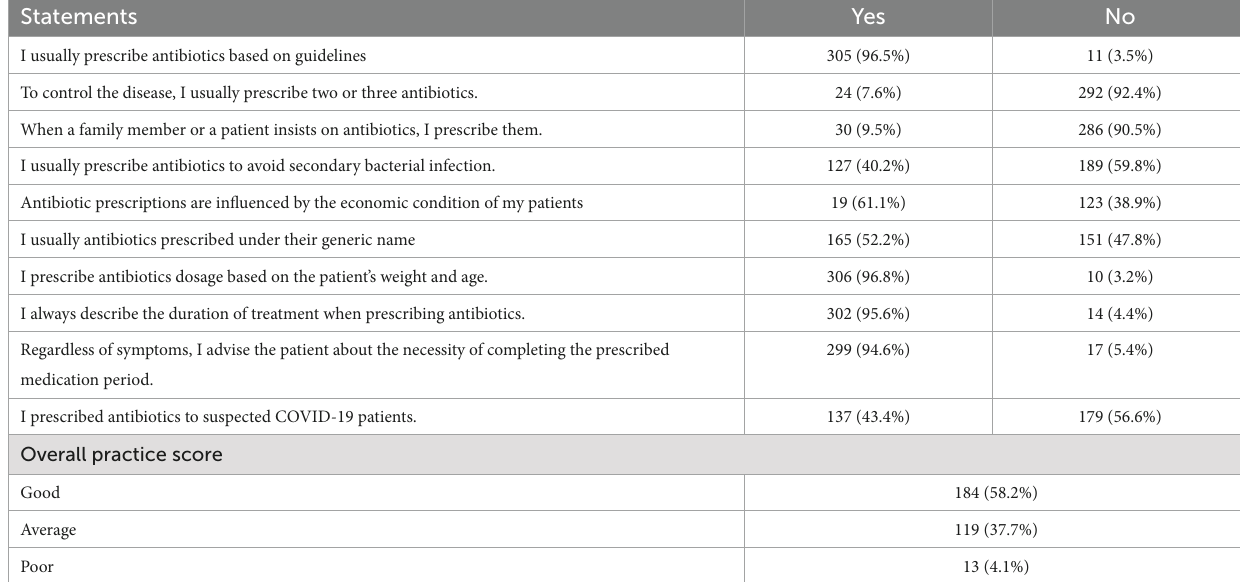
TABLE 4 Physicians’ responses to statements about antibiotic prescription